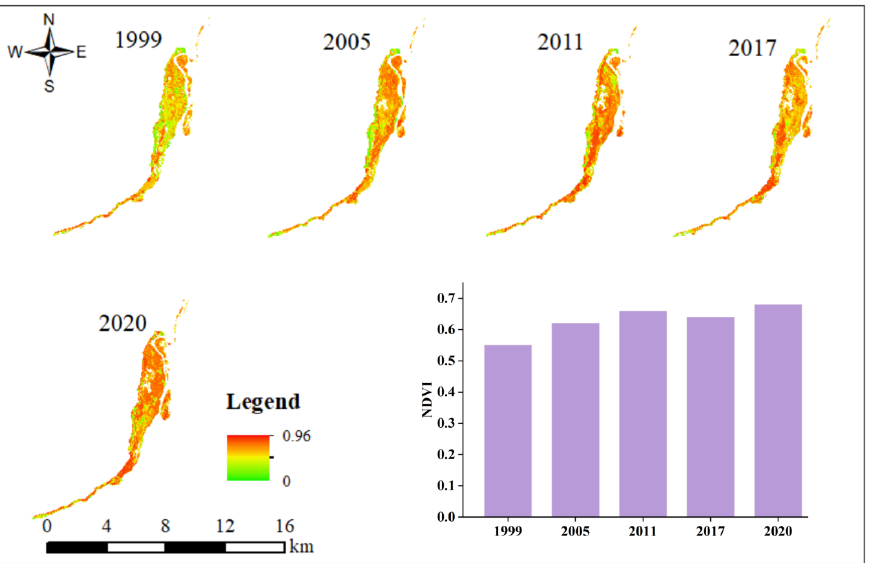
Figure 7. Spatial distribution map of NDVI in reed wetlands from 1999 to 2020.